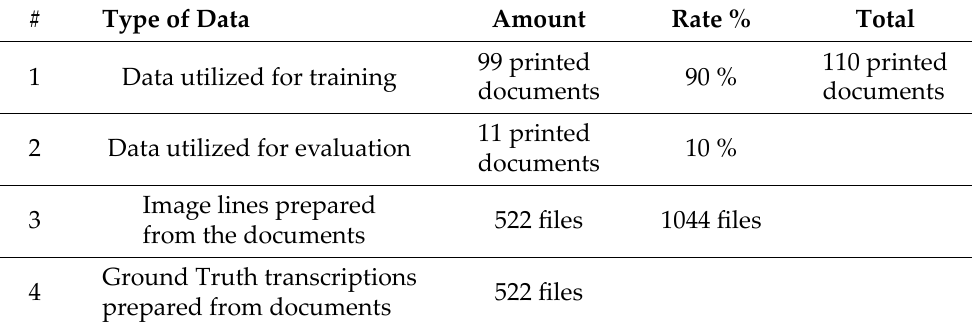
Table 9. Summary of data utilized for the training and evaluation process.